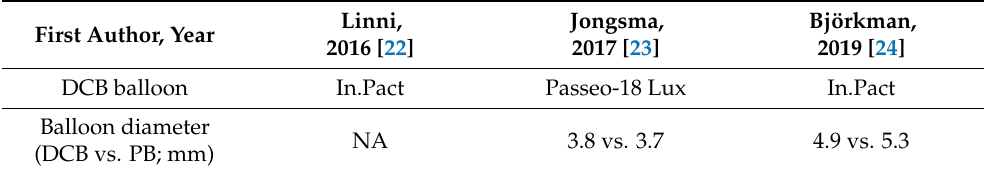
Table 2. Treatment